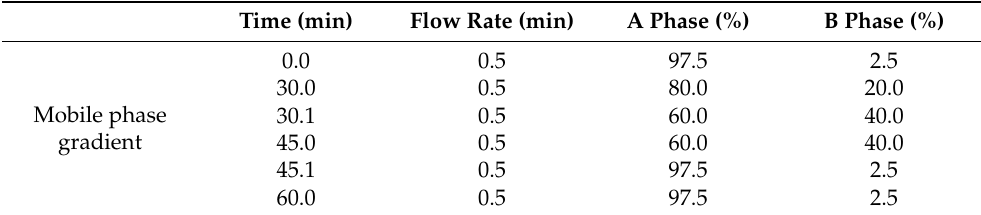
Table 1. Mobile phase